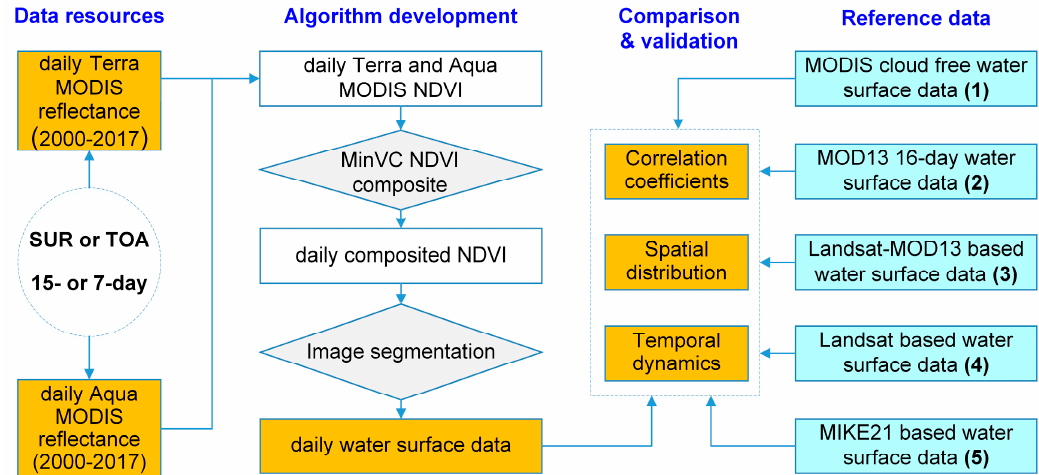
Figure 2. Workflow for daily water surface mapping and data validation.